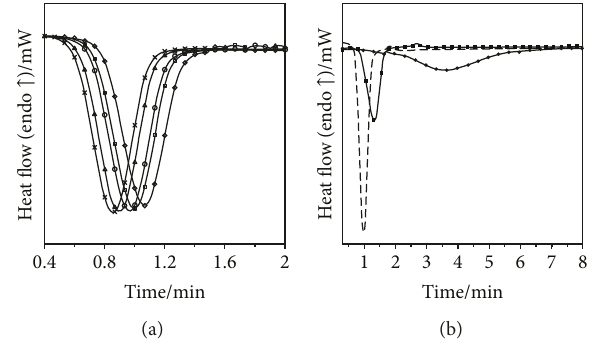
Figure 6: Crystallization endothermic curves for (a) linear poly( ε - caprolactone) homopolymer (PCL), symbols: ( × ) T = 16 ° C , ( Δ ) c T = 18 ° C , ( ○ ) T = 20 ° C , ( □ ) T = 22 ° C and ( ◊ ) T =24 ° C; and (b) c c c c linear PCL, SCL2 and HEMACL2 copolymers, crystallized at T =20 ° C, symbols: ( − -) linear PCL, ( ● ) SCL2 and ( ■ ) c